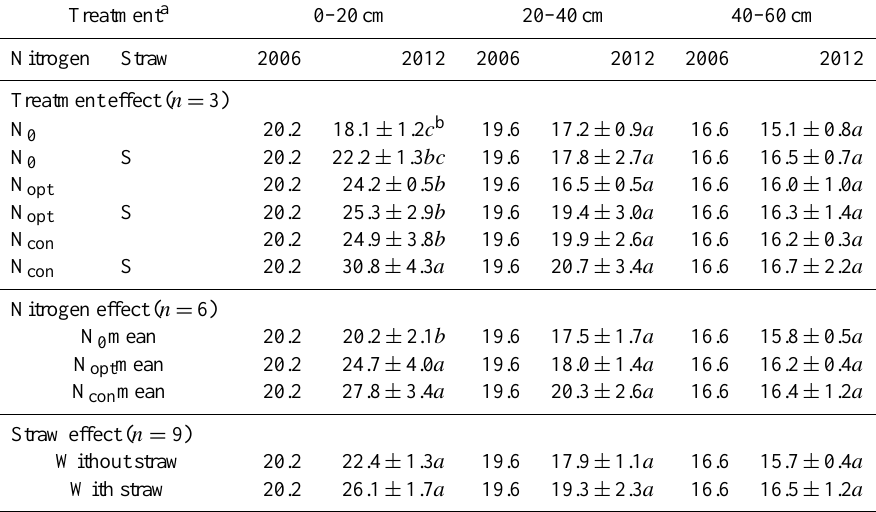
Table 4. Soil organic carbon (SOC) density (Mg Cha − 1 ) in 0–20, 20–40, 40–60cm in winter wheat–summer maize double-cropping system for the year 2006 and